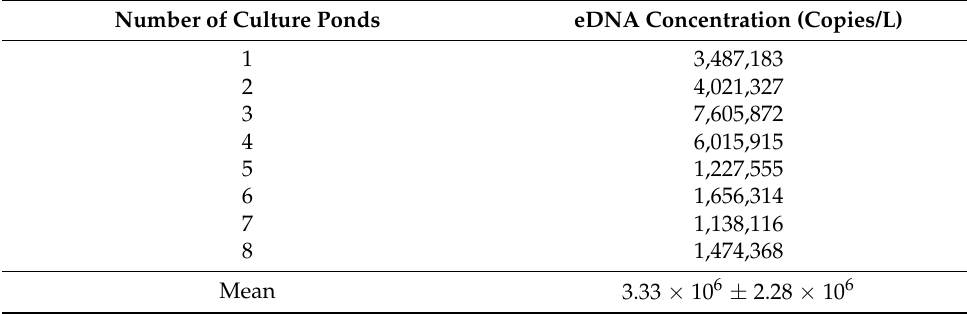
Table 2. The eDNA concentration in culture ponds. Number of Culture